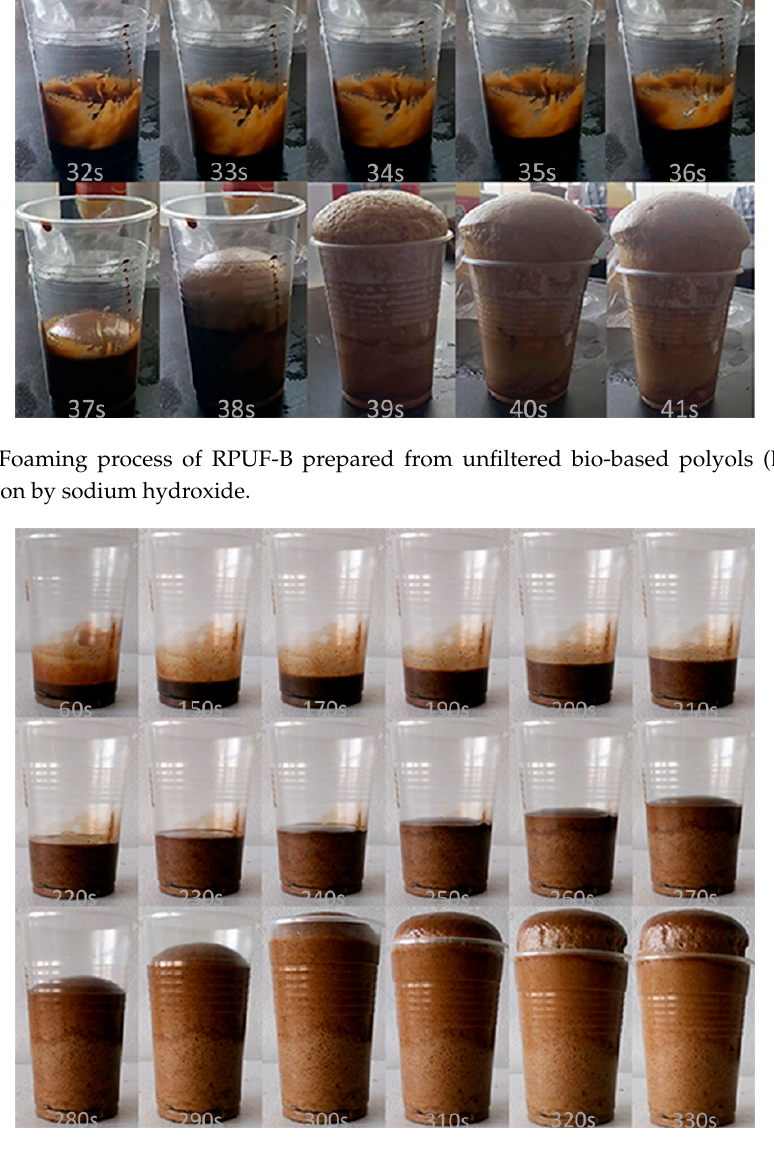
Figure 3. Foaming process of RPUF-D prepared from unfiltered BBPs without neutralization by sodium hydroxide.